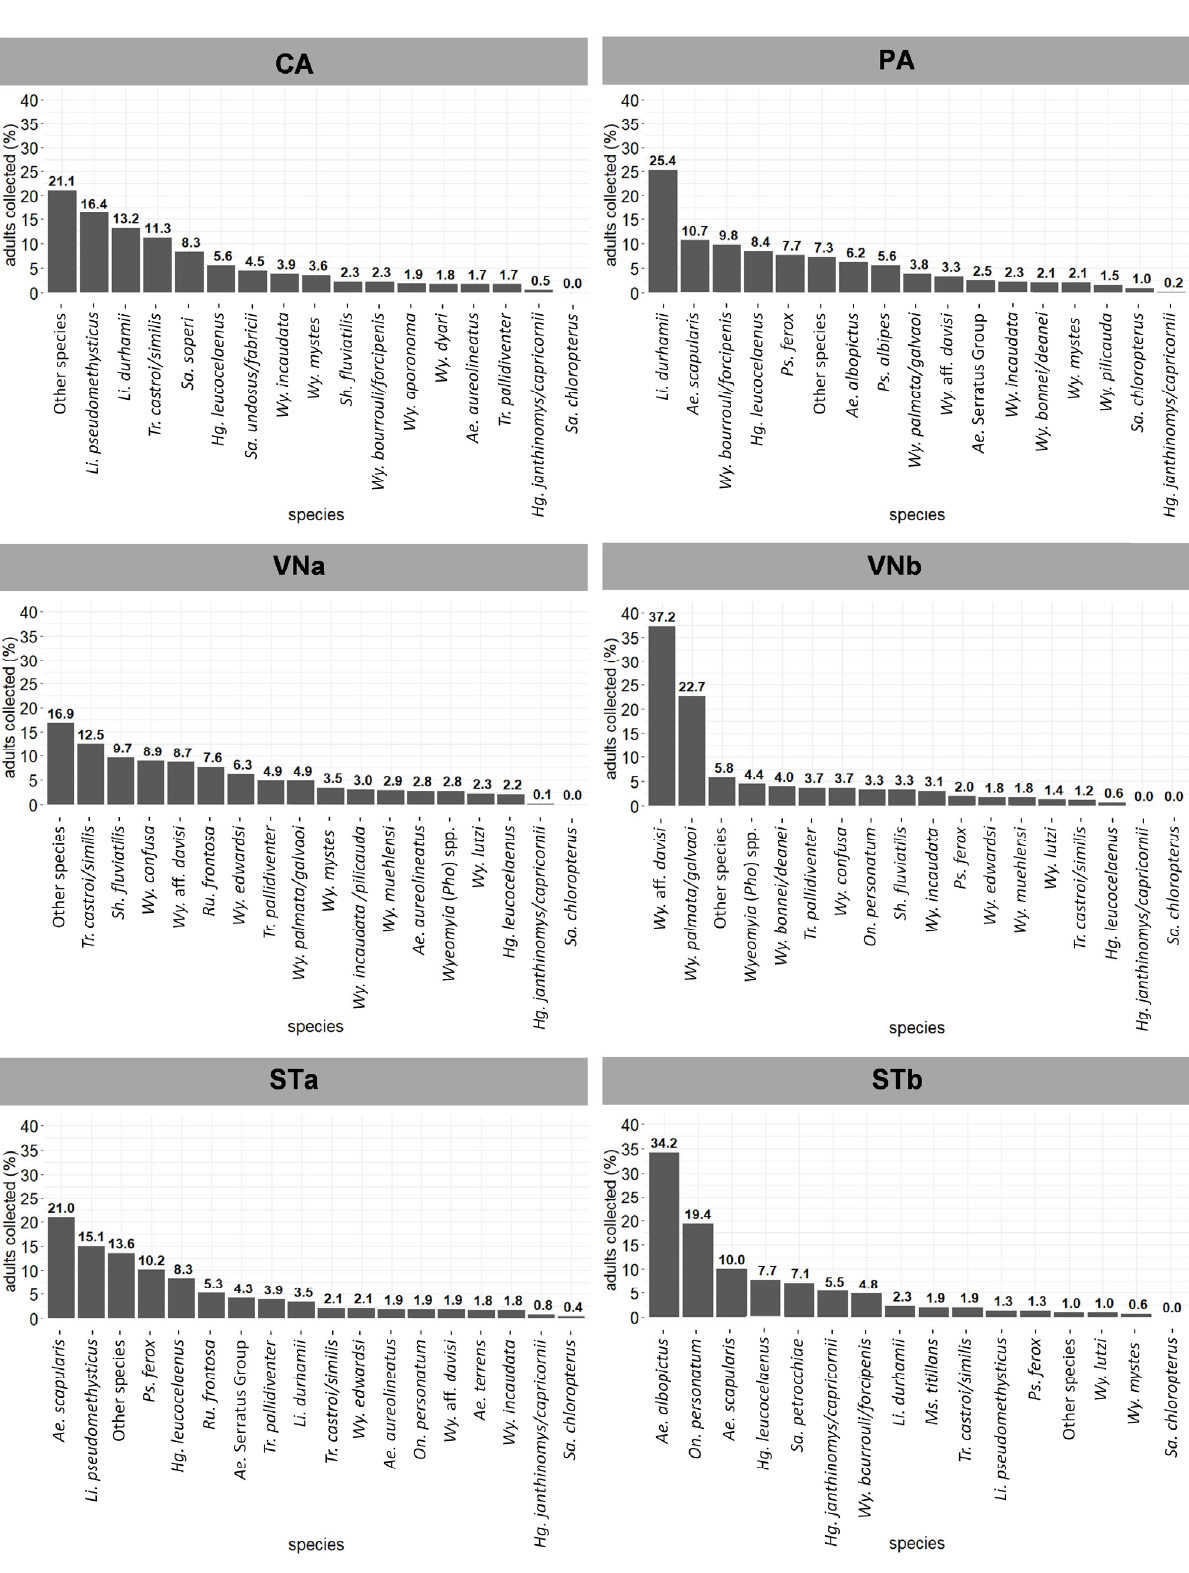
Figure 3. Most common mosquito species in adult sampling 1 in Cariacica (CA), Pancas (PA), Venda Nova do Imigrante (VNa and VNb), and Santa Teresa (STa and STb), Espírito Santo, February 2017.